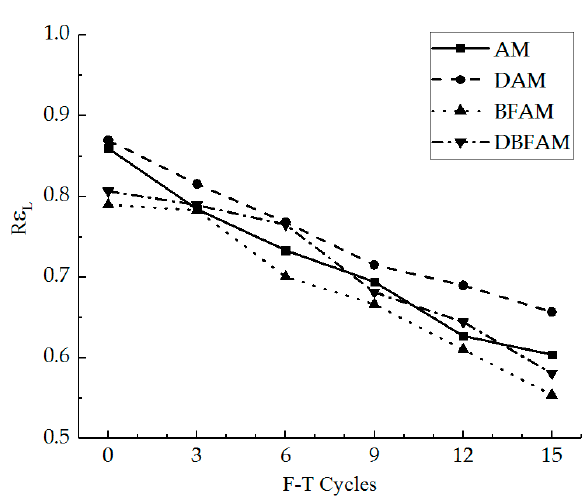
Figure 15. Linear zone strain ratio under F–T cycles.